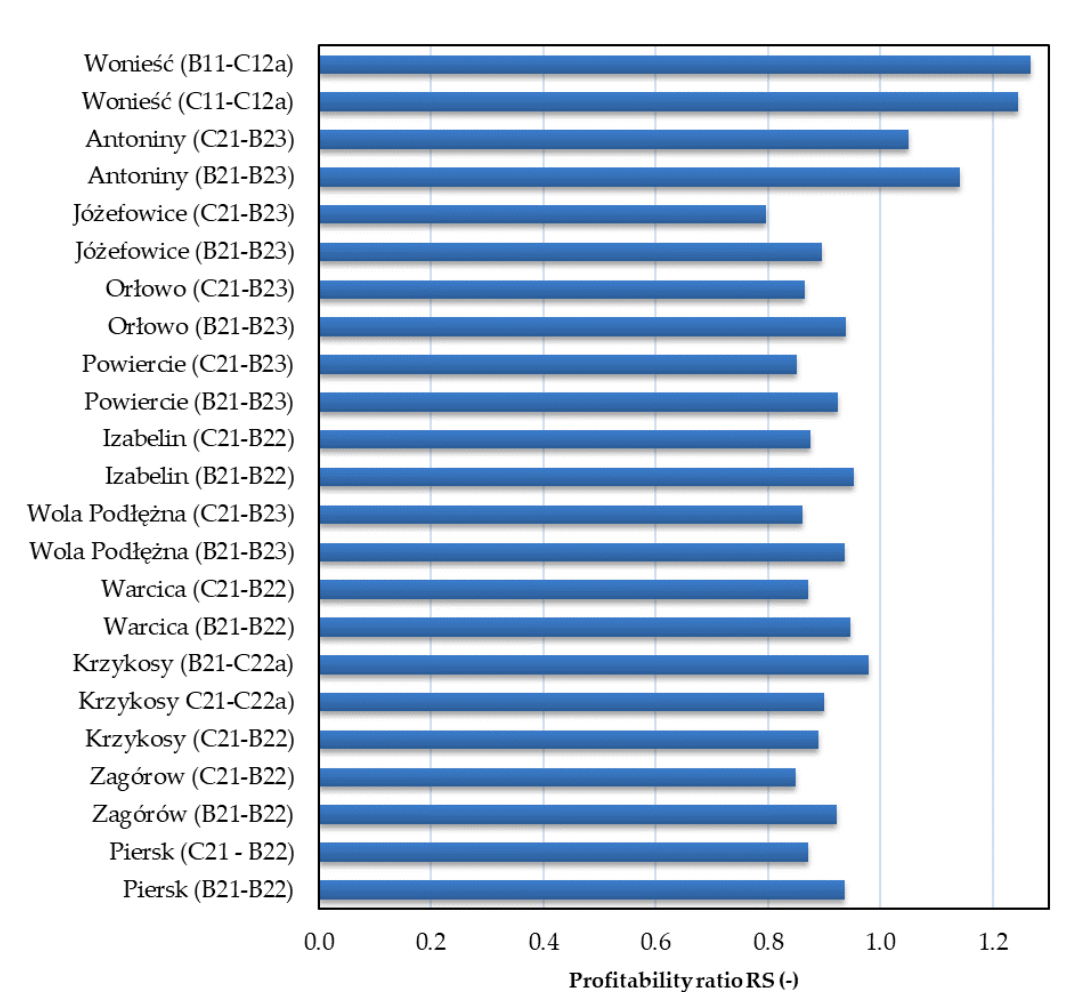
Figure 7. Average yearly cost of pump energy consumption (in PLN~0.22 €) before and after tariff change, achieved during the four-year research period. On average, 5% savings were achieved for all analyzed pumping stations (Figure 7). This is a significant amount considering the fact that these effects were obtained for free by changing the contract with the energy operator. In the analyzed four-year period, it was estimated that these savings could amount to almost PLN 0.5 million (EUR~110,000), and by 2021 these savings could even amount to PLN 1.7 million (EUR~374,000), as shown in Table 3.